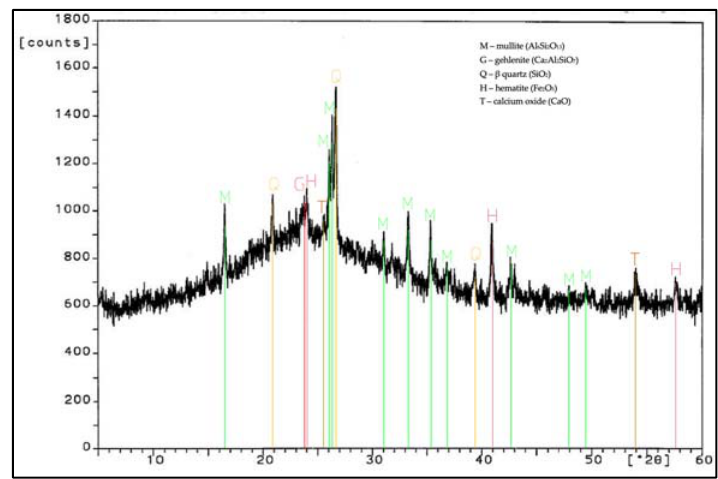
Figure 1. XRD pattern of siliceous fly ash (CFA) (based on results published in [45]).